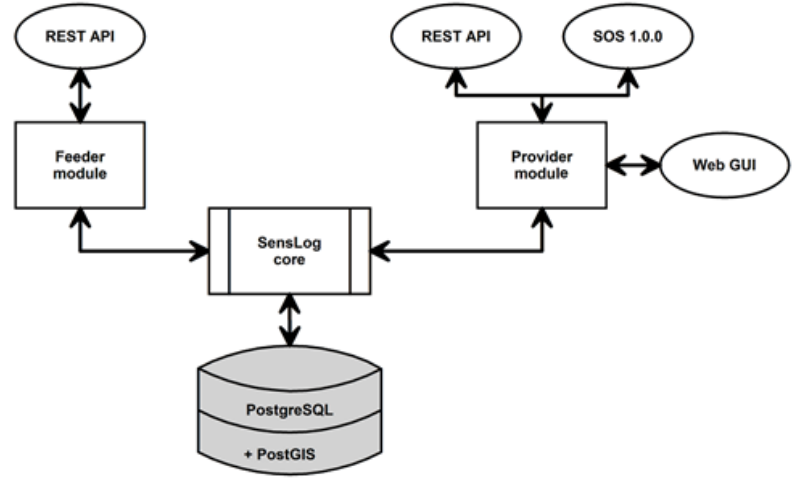
Figure 3. Overview diagram of SensLog application and communication interfaces.